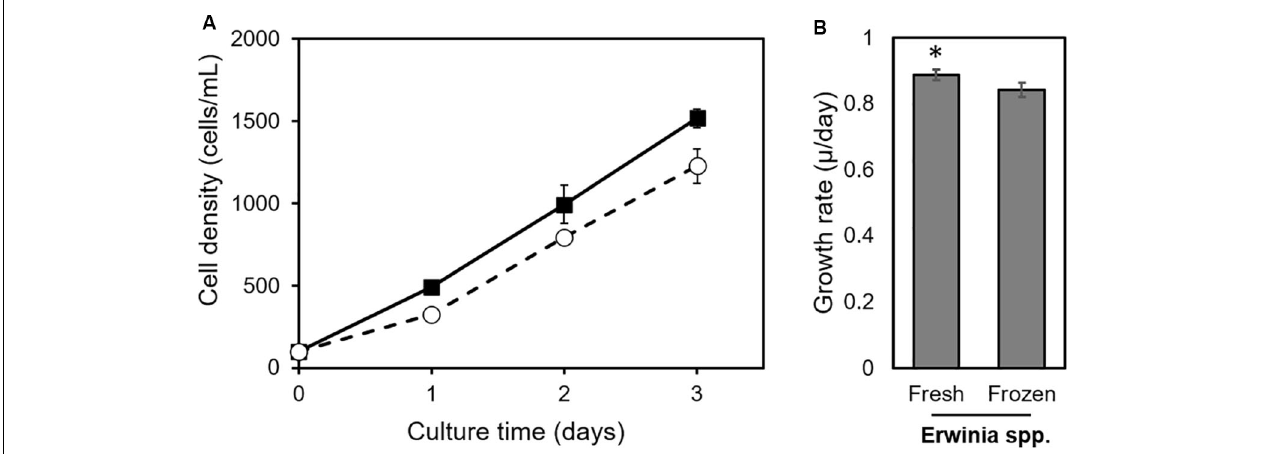
FIGURE 2 | Growth of ciliates fed with fresh or frozen Erwinia spp. (A) Cell density of Strombidium spp. NTOU1. Black rectangles, fed with fresh Erwinia spp. fodder; white circles, fed with frozen bacterial feeds. (B) Average growth rate of Strombidium spp. NTOU1. The asterisk indicates a significant difference between two groups (Student’s t- test, p < 0.05). The error bars represent the standard deviations of the average from three independent experiments.